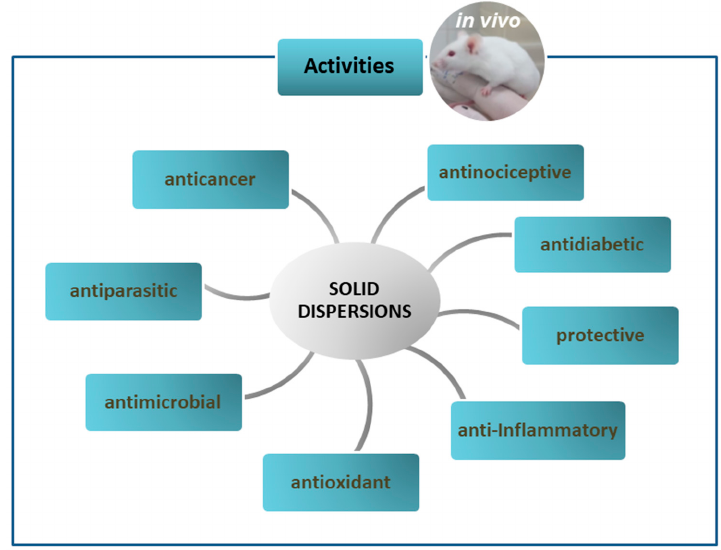
Figure 3. In vivo activities of solid dispersions.